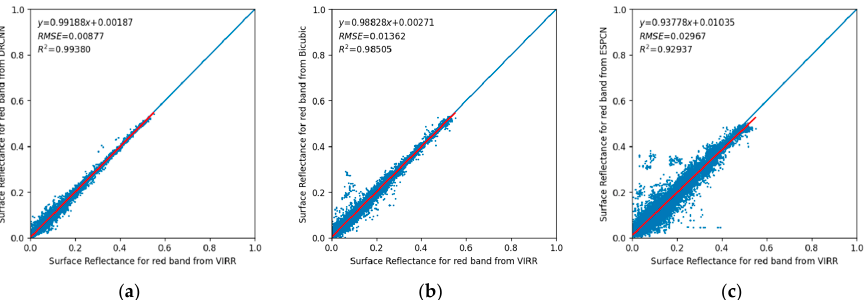
Figure 8. Scatterplots of the downscaled surface reflectance in the red band by ( a ) the DRCNN, ( b ) the bicubic interpolation method and ( c ) the ESPCN method versus the surface reflectance in the red band from the preprocessed MOD09Q1 product over the OLIVE sites in 2015. Figure 9 shows time series of the downscaled surface reflectance in the red band from the DRCNN, the bicubic interpolation method and the ESPCN method, and the surface reflectance in the red band from the preprocessed MOD09Q1 product in 2015, as well as the corresponding time series of NDVI at the Zhangbei, Collelongo, Barrax and Maragua sites. In Figure 9, the blue line represents the surface reflectance in the red band from the preprocessed MOD09Q1 product, and the red line represents the downscaled surface re- flectance in the red band from the DRCNN. Excellent agreement was achieved between the time series of the downscaled surface reflectance in the red band from the DRCNN and the time series of the surface reflectance in the red band from the preprocessed MOD09Q1 product for the entire year at these sites, and the corresponding time series of NDVI were in good agreement, which further illustrates the good performance of the DRCNN to downscale the surface reflectance of the MOD09A1 product. However, the surface reflectance downscaled by the ESPCN method is not stable. For example, the time series of the surface reflectance downscaled by the ESPCN method at the Maragua site also showed significant fluctuations.